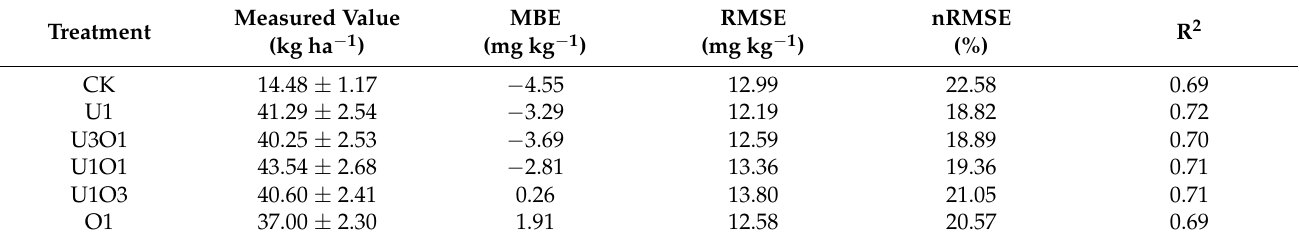
Figure 3. The modeled and measured soil NO 3 − -N content (0–20 cm) under different treatments. The measured data are the means of three replicates and vertical bars indicate standard errors of replicates. Table 4. Statistical evaluation between the modeled and measured daily NO 3 − -N content (mg kg − 1